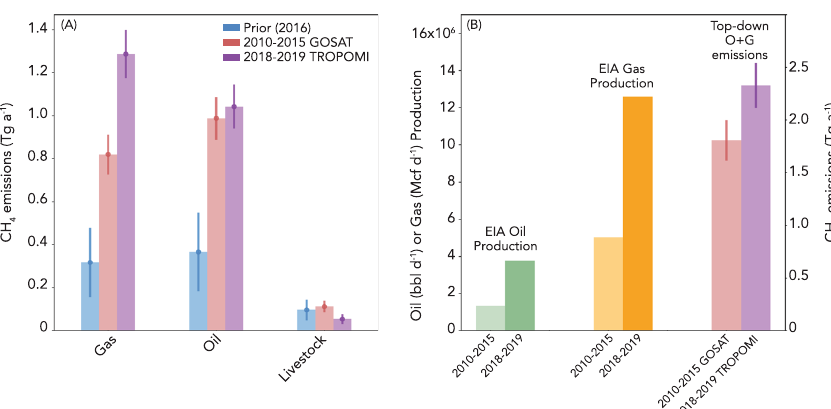
Fig. 4 Aggregated CH 4 emissions and reported production from the Energy Information Administration (EIA) in the Permian Basin. Panel a shows top- down emissions optimized from the independent fl ux products from Fig. 3 aggregated to the basin. Error bars are an integration of prior and posterior error covariance matrices for the respective emission sectors. Panel b compares mean 2010 – 2015 and May 2018 – March 2019 EIA production data 21 for oil and gas sectors to the oil + gas emissions from panel a